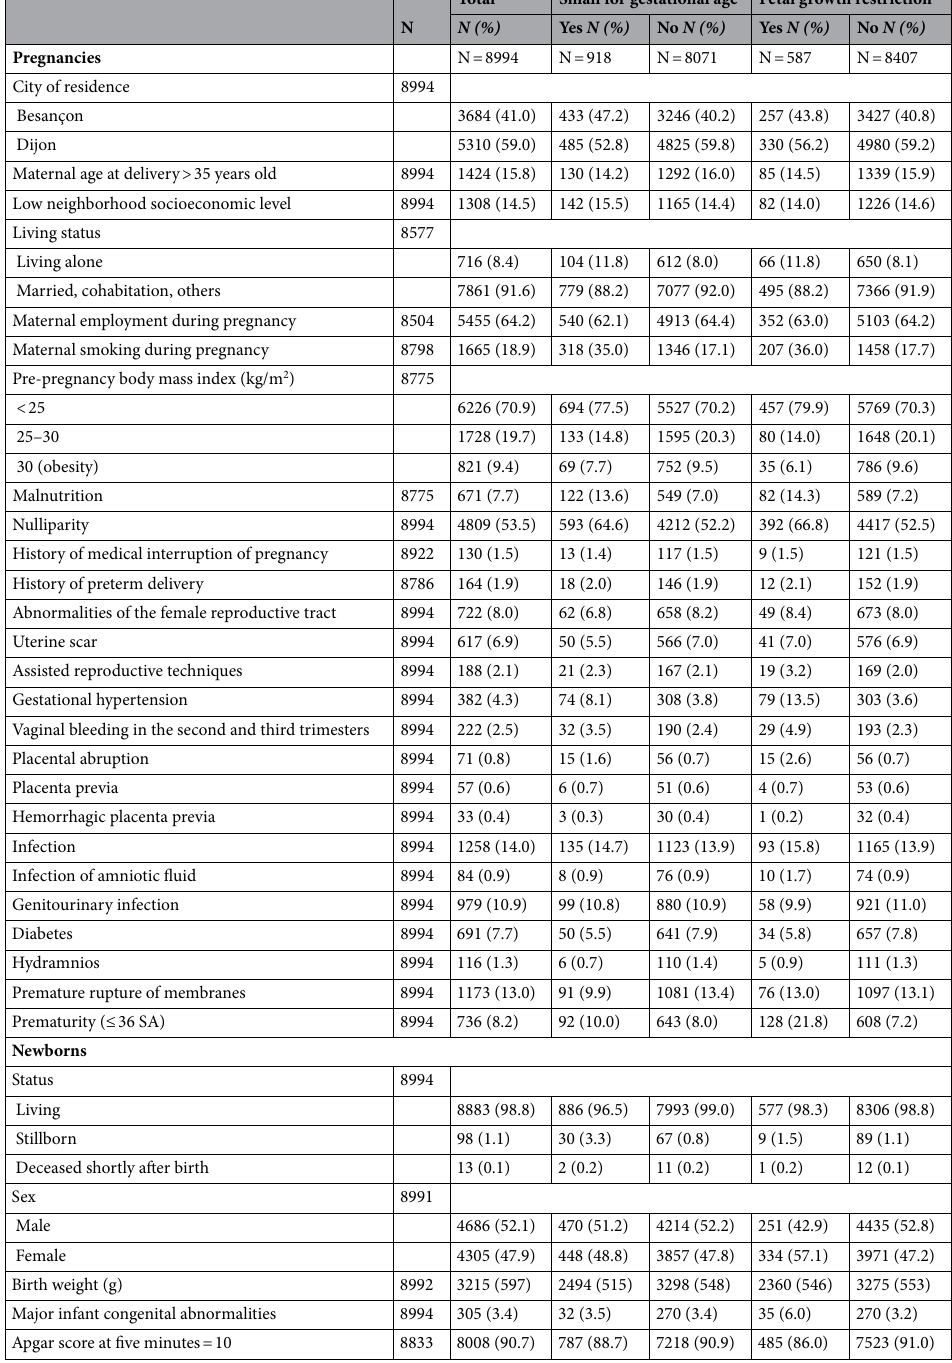
Table 1. Pregnancy and newborn characteristics according to fetal growth restriction and small for gestational age status, 2005–2009 (N = 8994). N: number; N (%): number (percentage) except for birth weight which is described by mean (standard deviation). 1 Lower than 10th centile of birth weight for gestational